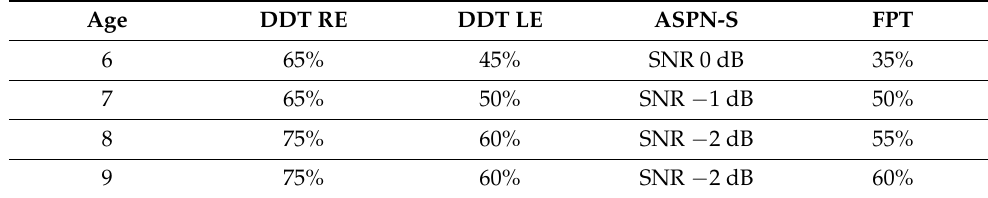
Table A3. Reference values for the APD test results